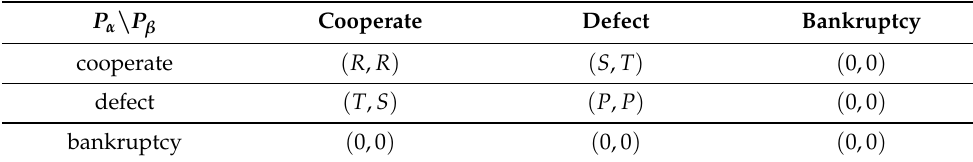
Table 3. Payoff bi-matrix for a game with